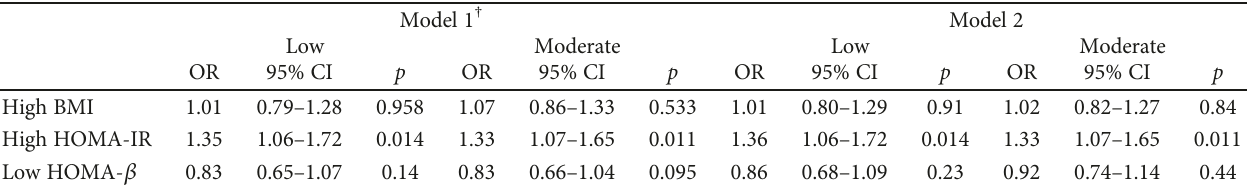
Table 6: Multivariate logistic regression for PA levels and BMI, HOMA-IR, and HOMA- β